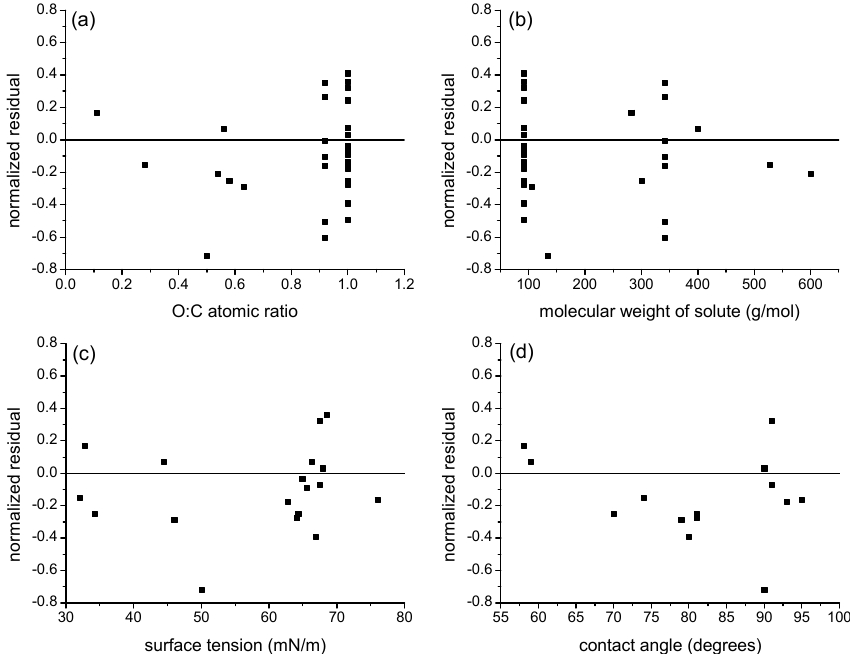
Fig. 7. Normalized residuals from the data presented in Fig. 6, plotted as a function of (a) O:C atomic ratio, (b) molecular weight of solute, (c) surface tension and (d) contact